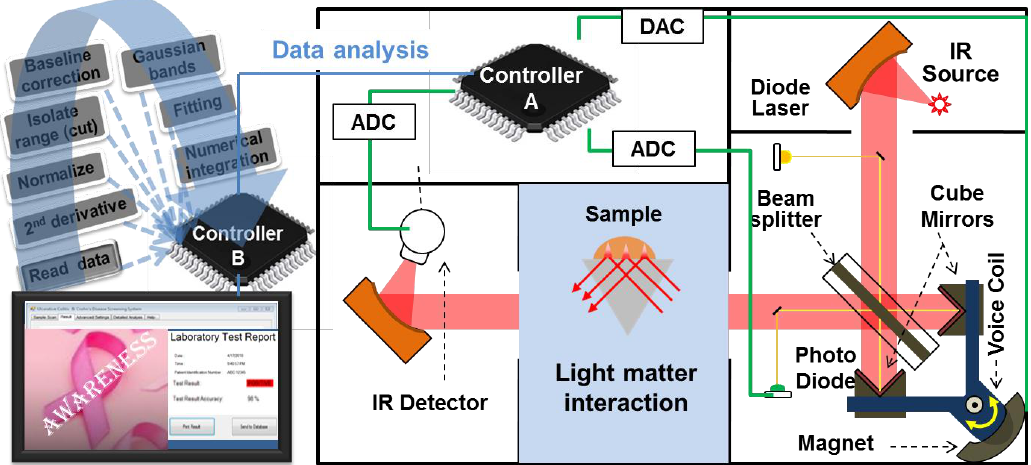
Figure 6. Schematic of attenuated total reflection Fourier transforms infrared (ATR-FTIR) spectrometer integrated with two micro-controllers (micro-processors) A and B. Controller A extracts the information about the signal–sample interaction, while controller B stores the spectral analyzing software application in the clinical domain.